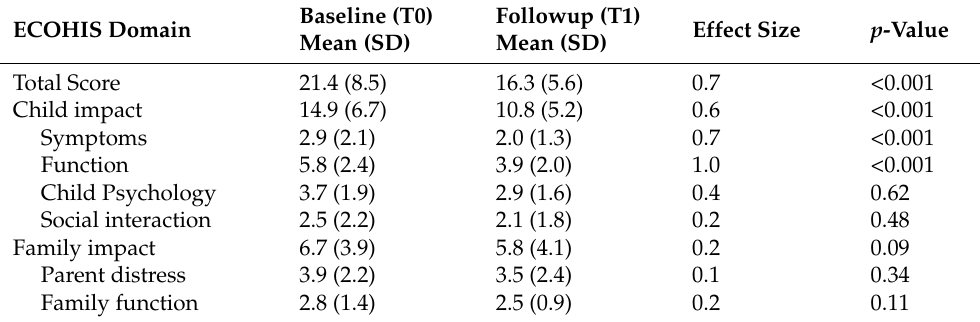
Table 2. Overall Early Childhood Oral Health Impact Scale (ECOHIS), child impact section (CIS), and family impact section (FIS) scores (Baseline, T1) for children who received SDF treatment.